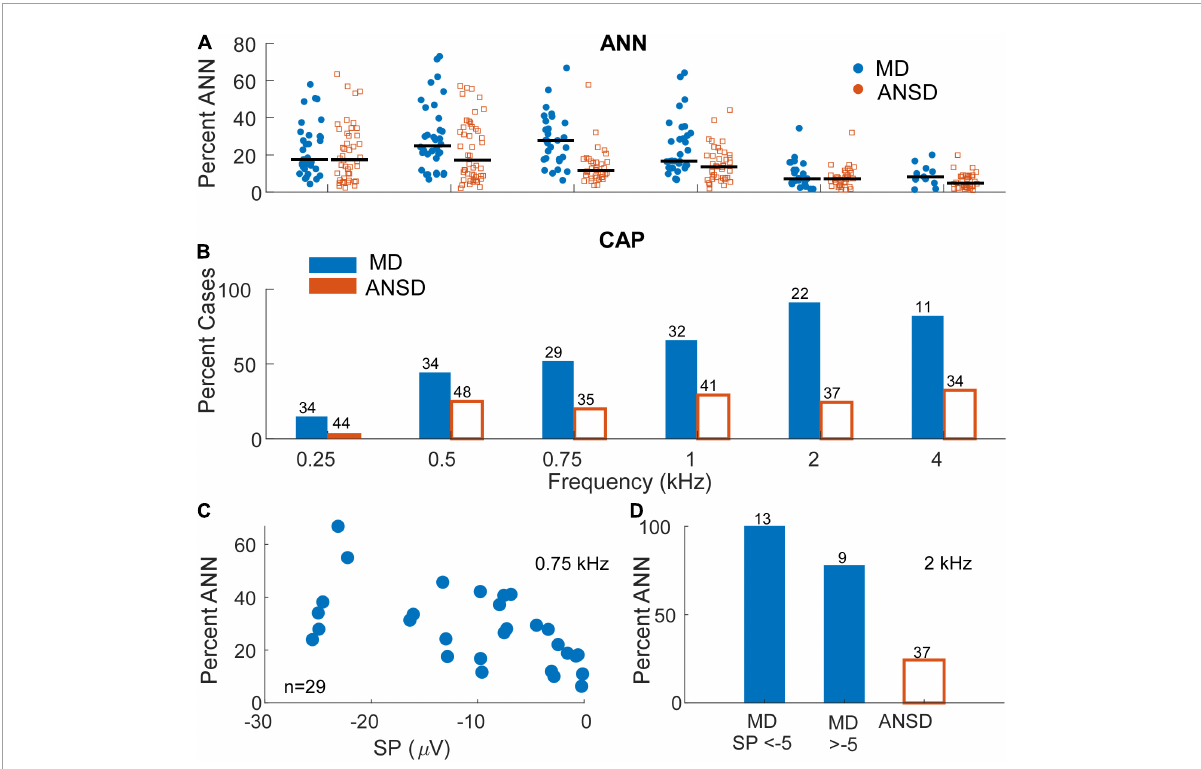
FIGURE5 Distribution and prevalence of markers of neural activity in electrocochleography (ECochG) responses of the tested populations. (A) The percentage of the alternating current (AC) response attributable to auditory nerve neurophonic (ANN) in subjects with auditory neuropathy spectrum disorder (ANSD) and Meniere’s disease (MD) across frequencies. As expected, signals in response to stimuli between 250 and 1000 Hz demonstrated the greatest evidence of significant ANN contribution in both populations with signals recorded in Meniere’s subjects demonstrating relatively higher range of neural activity at 500 and 750 Hz. Black bars represent mean percentage of ANN contribution in each group. (B) The proportion of the ECochG signals in both tested populations that demonstrated a compound action potential (CAP). Signals recorded in subjects with MD demonstrated an identifiable CAP in most subject, in contrast to ANSD subjects where the proportion was small. The proportion of cases with a CAP was greater for higher frequencies in the subjects with MD. (C) The proportion of the ANN for MD cases as a function of the summating potential (SP) for one frequency (750 Hz) where the ANN was relatively strong [as in panel (A) ] and there were many cases with large SPs (as in Figure 3B ). (D) The proportion of the CAP separated by SPs above and below –5 µ V in response to a high frequency tone burst (2 kHz). In both panels (A,B) the neural activity was high in cases with both large and small